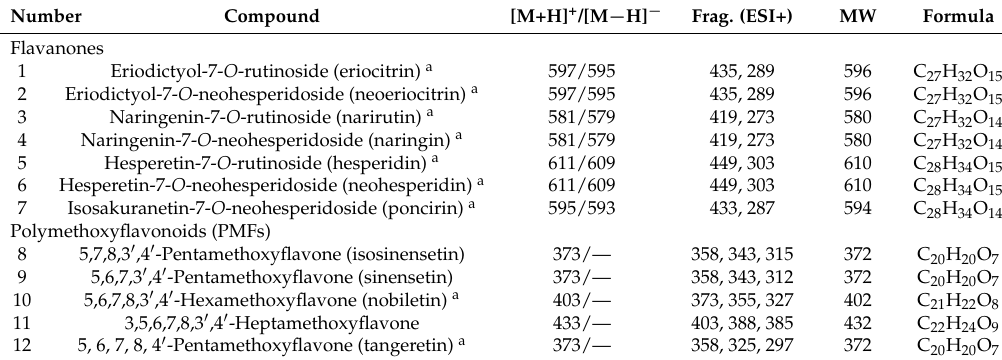
Figure 3. Representative chromatogram of flavonoids with antioxidant properties from ethanol extract of Aurantii fructus obtained using HPLC–DAD ( λ = 284 nm) coupled with Q–TOF–MS. Table 3. Mass spectrometry data of the main flavonoids with antioxidant properties from Aurantii fructus.